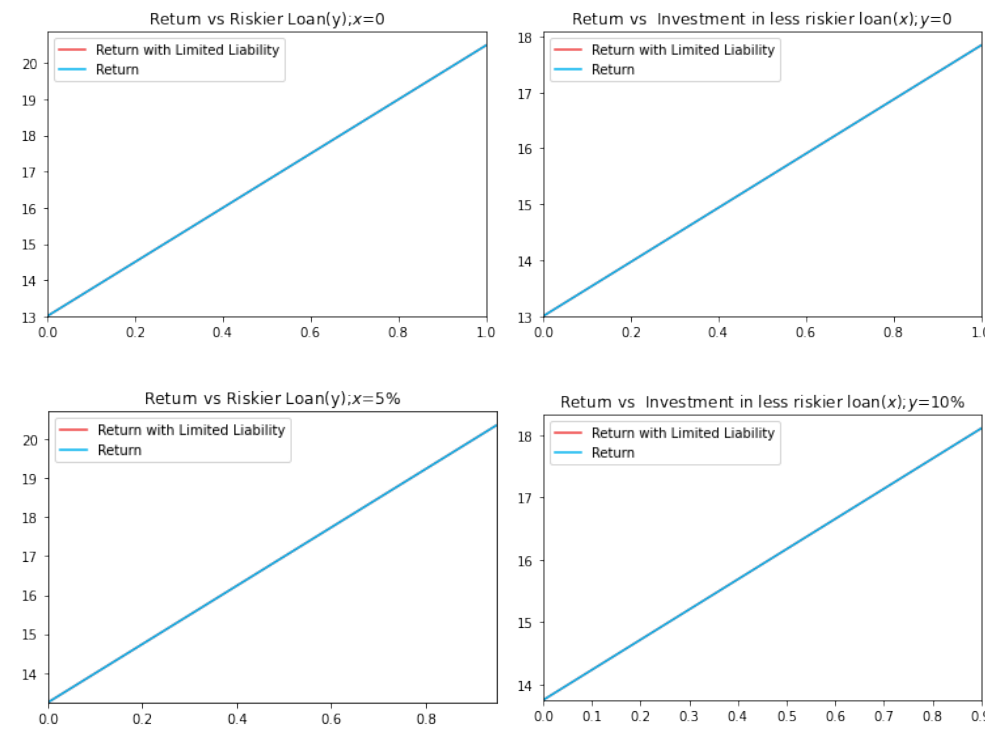
Figure 6. Expected Returns versus risky loans keeping the Leverage Ratio at